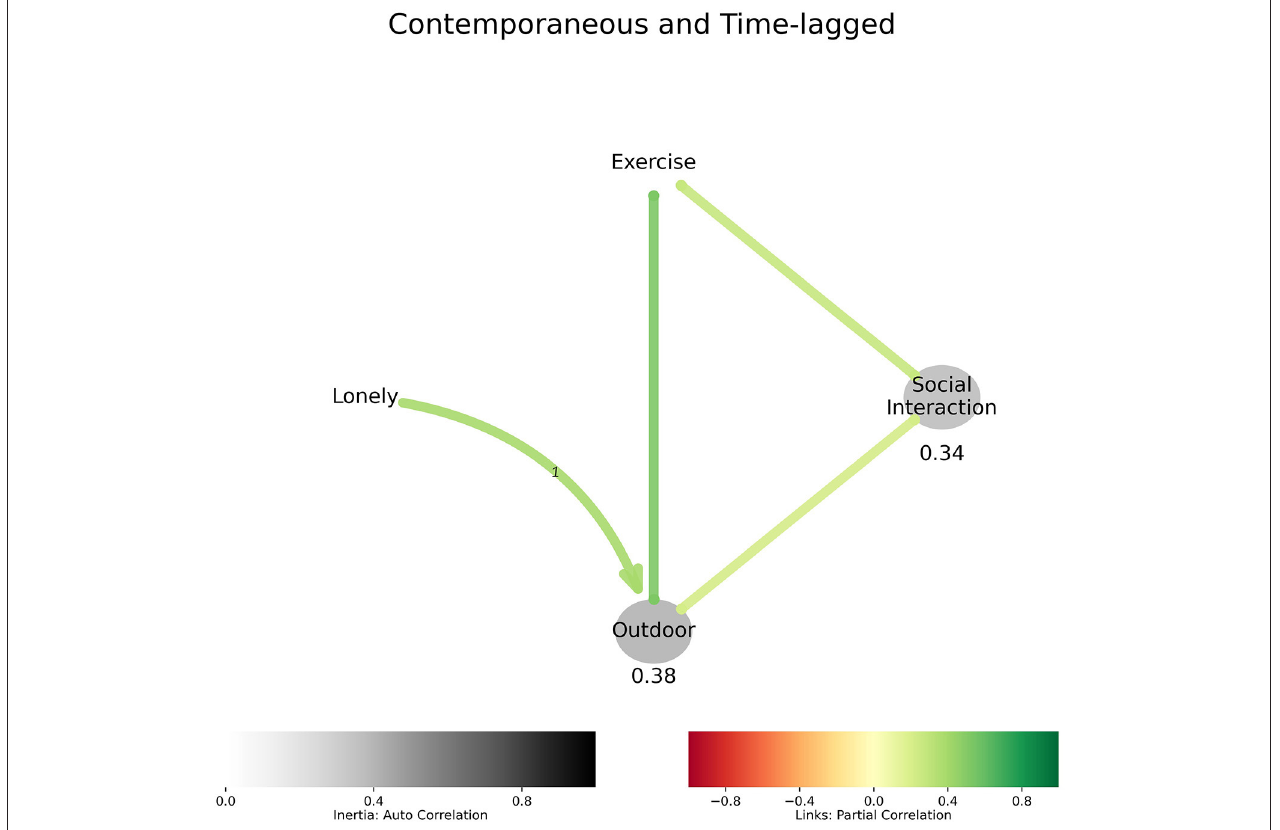
FIGURE 2 | Behavior model describing how loneliness relates to behavior: Loneliness precedes being outdoor, which is associated with exercise and social interaction.